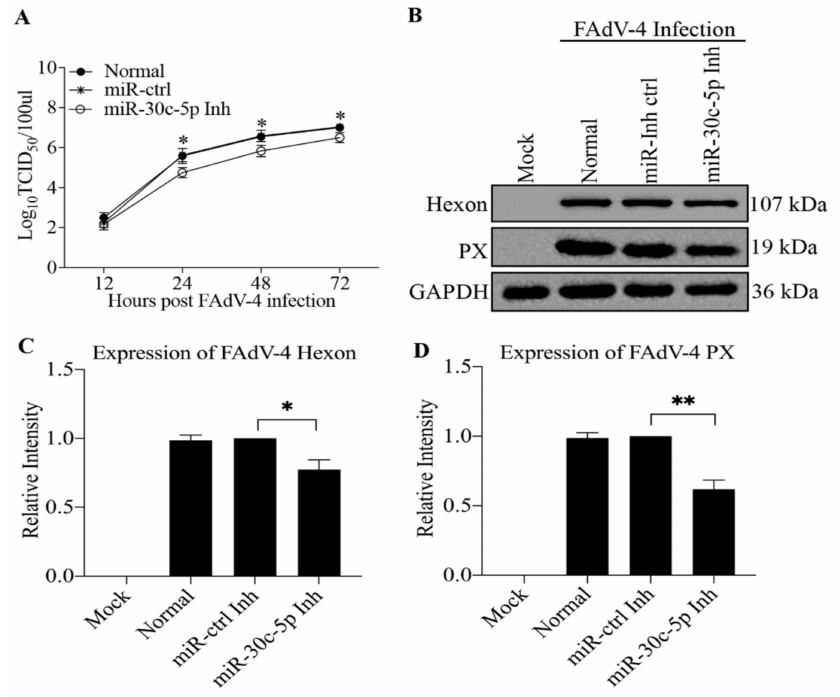
Figure 4. Inhibition of endogenous gga-miR-30c-5p suppresses FAdV-4 replication. ( A ) Knockdown of endogenous gga-miR-30c-5p in LMH cells suppressed FAdV-4 replication. The LMH cells were transfected with gga-miR-30c-5p inhibitor (Inh) or miR-Inh-control (ctrl). Twenty-four hours after transfection, the cells were infected with FAdV-4 at an MOI of 1. At different time points (12, 24, 48, and 72 h) after FAdV-4 infection, the viral loads in the cell cultures were determined by TCID 50 assays. ( B – D ) The LMH cells were transfected with gga-miR-30c-5p Inh or miR-Inh-ctrl. Twenty-four hours after transfection, the cells were infected with FAdV-4 at an MOI of 1. Twenty-four hours after FAdV-4 infection, cell lysates were prepared and subjected to Western Blot analysis using anti-Hexon and anti-PX antibodies. Endogenous GAPDH expression was examined as an internal control. The band densities of Hexon and PX shown in panel ( B ) were quantitated by densitometry, as shown in panels ( C , D ). The relative levels of Hexon and PX were calculated as follows: band density of Hexon or PX/that of GAPDH. The significance of the differences between gga-miR-30c-5p Inh-transfected cells and miR-Inh-ctrl in terms of viral growth was determined by ANOVA. Data are representative of three independent experiments and presented as means ± SD. (** stands for p < 0.01; * for p <